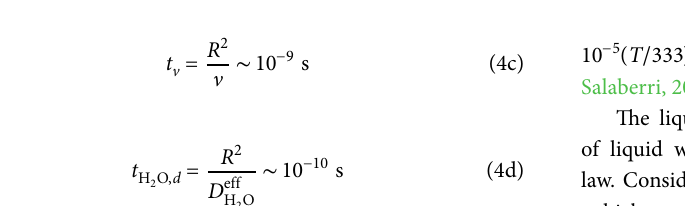
FIGURE 4 Schematic of tailored structures to mitigate cathode flooding in primary nanopores of the idealized bi-functional cathode CL examined in this work: (A) straight cylindrical nanopore with a PTFE coating added on the exterior surface of the nanoporous shell, and (B) tapered nanopore with increased Laplace pressure to enhance transport of liquid water from a hydrophobic PTFE coating toward hydrated ionomer (connected to the anode side through the